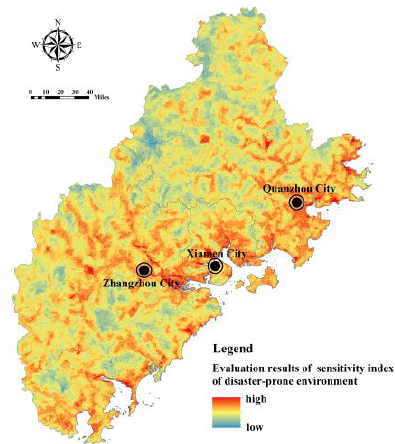
Figure 8. Assessment of the index of hazard of disaster-causing factors in Fujian Delta.